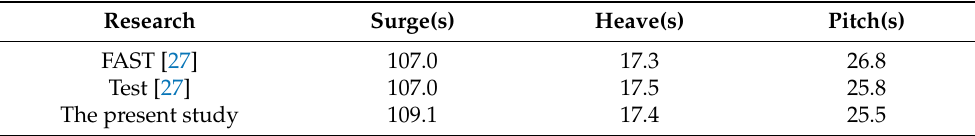
Table 3. Summary of the verifications for dynamics simulation.